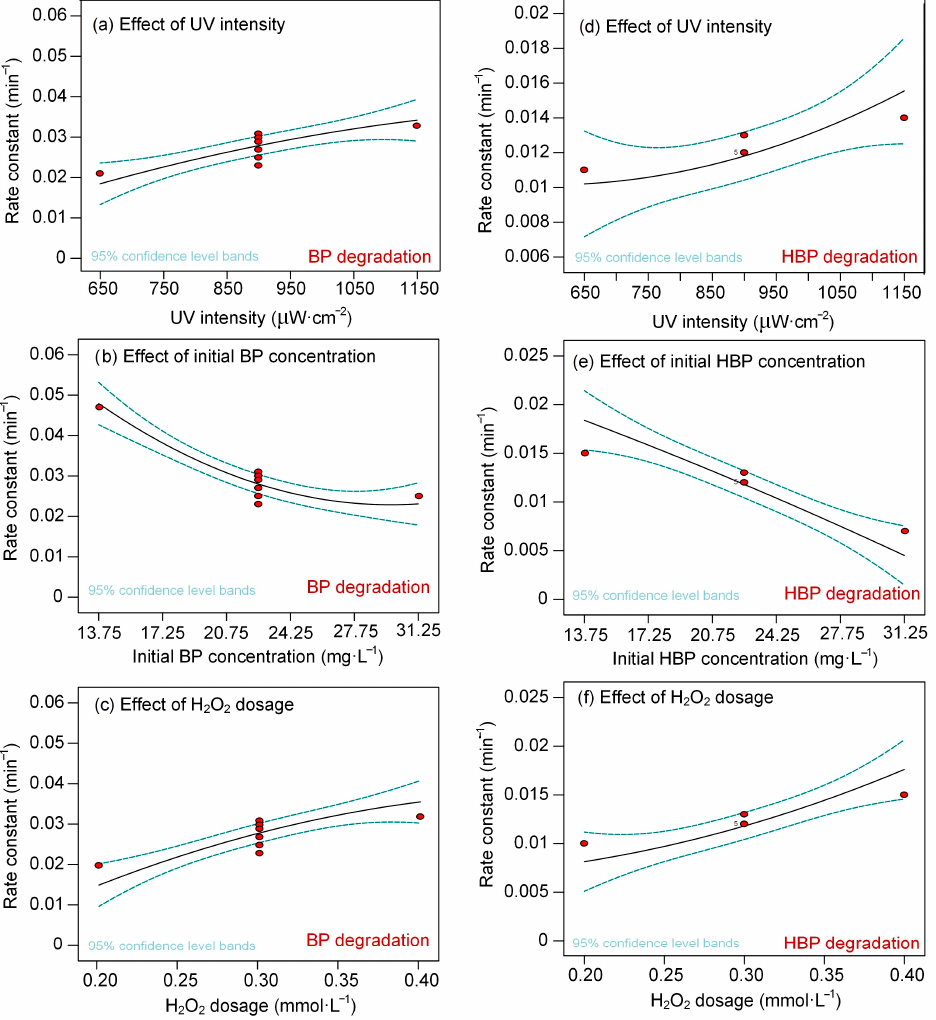
Figure A1. The effect of single factor on the rate constants of BP and HBP degradation. (The black solid line and two blue dotted lines represent the effect of single factor and 95% confidence level bands.).